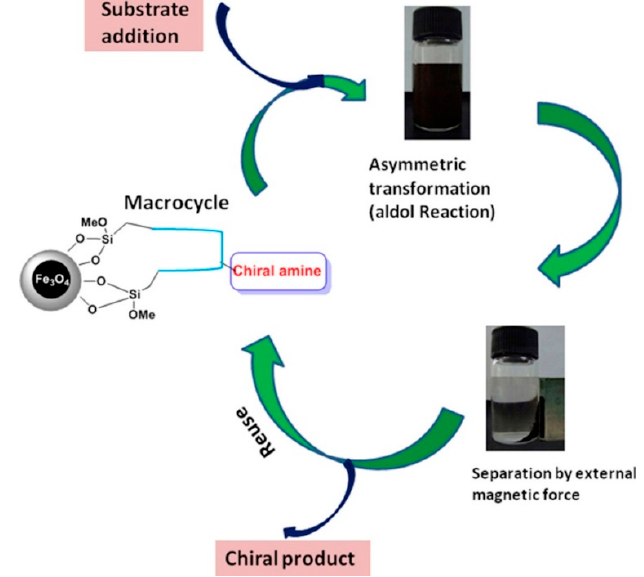
Figure 5. Mechanism of purification of asymmetric aldol reaction products by means of chiral MNPs. Reprinted with permission from [59], Copyright Elsevier.